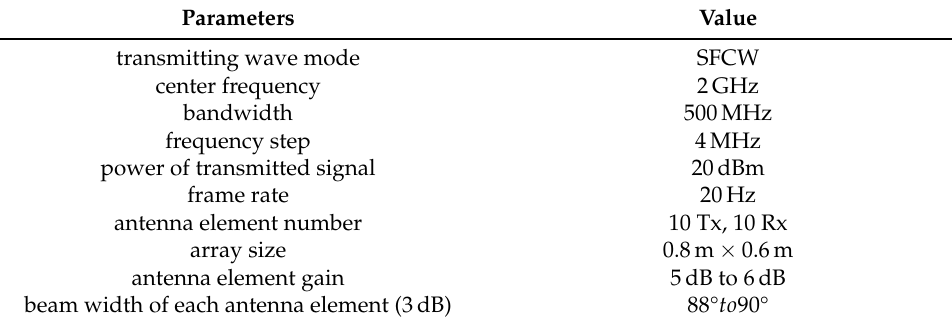
Table 2. Key parameters of the MIMO radar